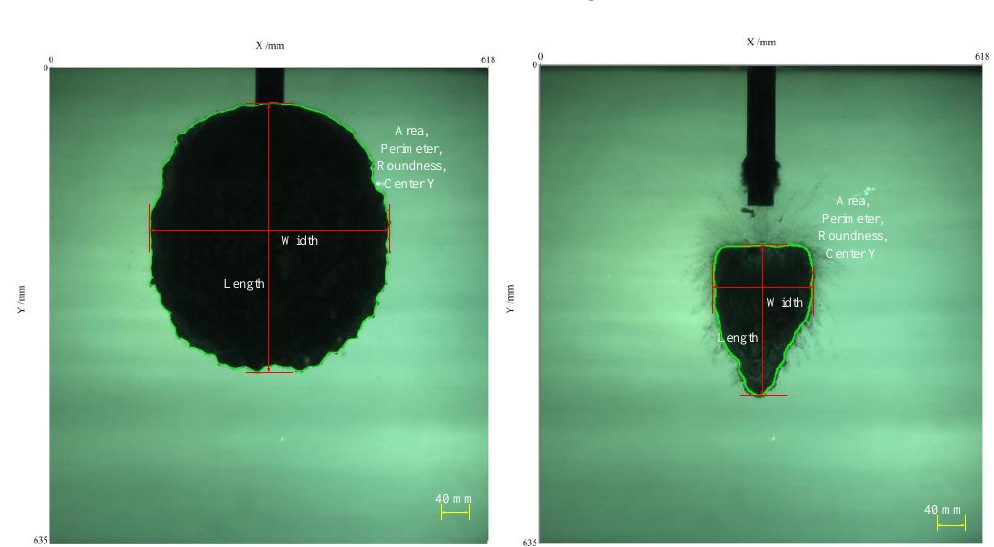
Figure 10. Post-processed bubbles of the gas jet generated by underwater detonation.